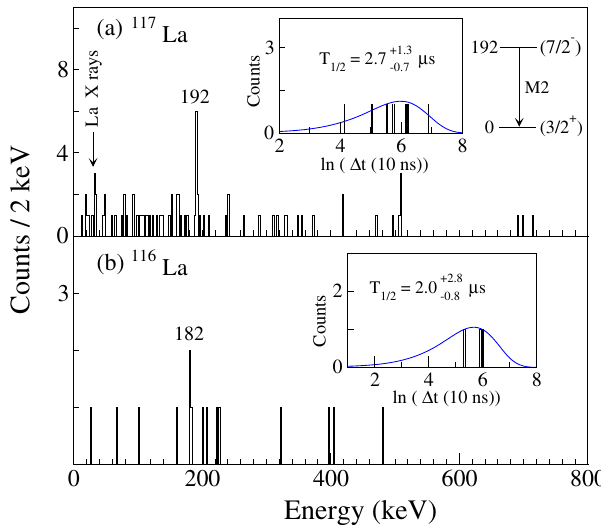
Fig. 2 Experimental data illustrating the two observed isomeric- γ transitions. a γ -ray energies detected within 8 μ s of a recoil implantation into the DSSD and followed by a proton decay from 117 La in the same quasipixel. The inset shows the time distribution of 192-keV γ -rays selected in this way. The fi t of the lifetime using the maximum likelihood method 35 is indicated by the blue curve. The proposed corresponding level scheme obtained for 117 La is indicated to the right. b Same as a tagged by 116 La proton decays and for 182-keV γ